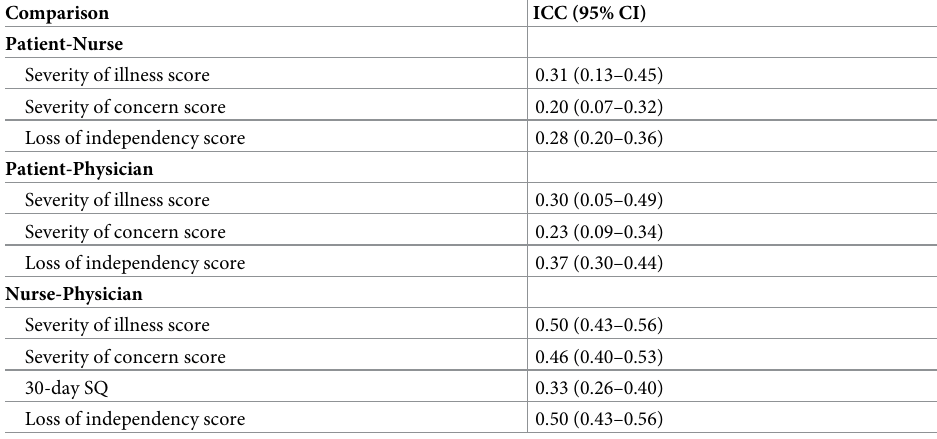
Table 4. Intraclass correlation coefficients with 95% CI for the different